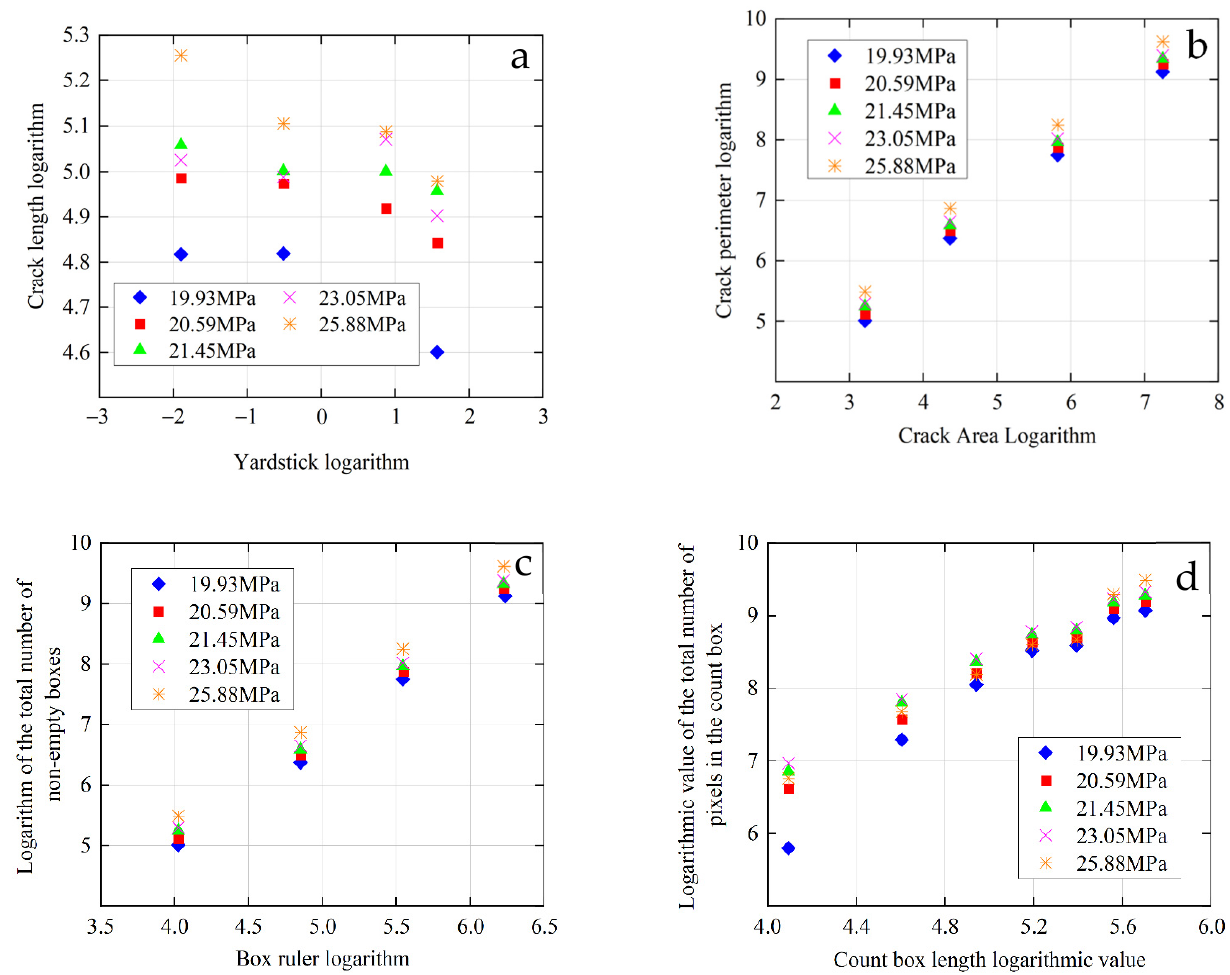
Figure 8. Calculation results of crack fractal dimension: ( a ) the yardstick logarithmic method; ( b ) the island method; ( c ) the box-counting method; ( d ) the sandbox method.